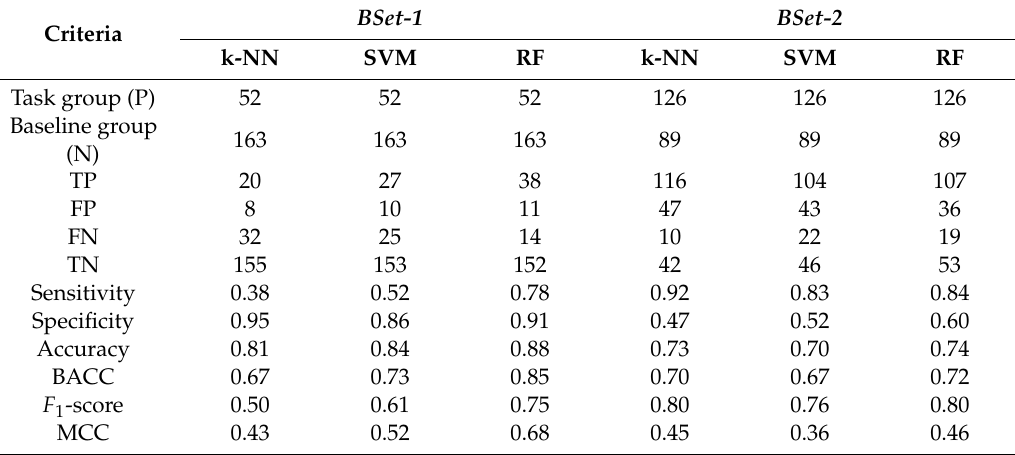
Table 5. Performance summary of the classifiers for binary classification on the test